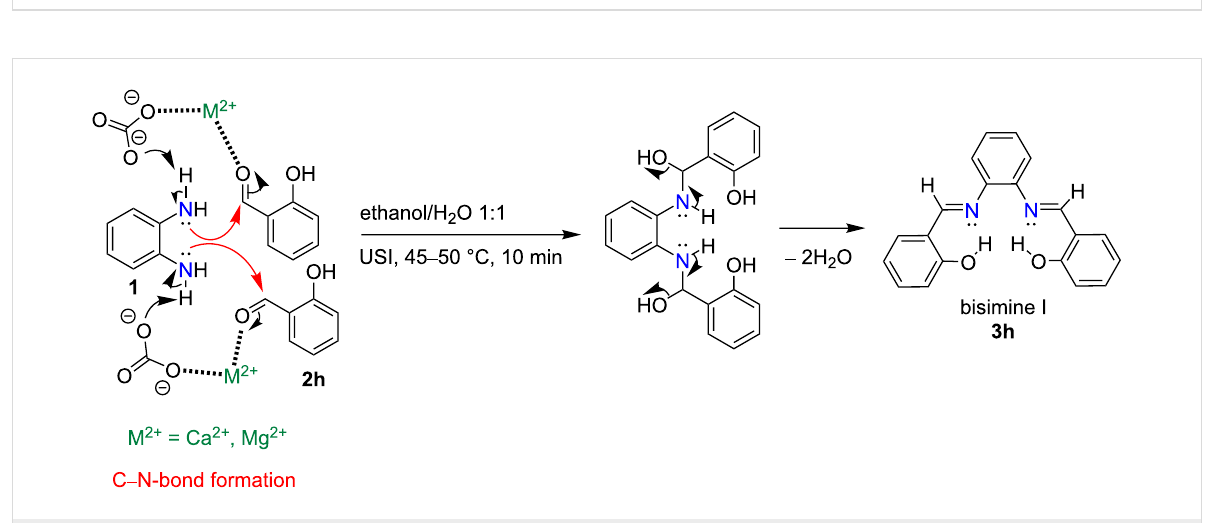
Scheme 2: Unexpected formation of the bisimine I, 3h , from o -phenylenediamine ( 1 ) and salicylaldehyde ( 2h